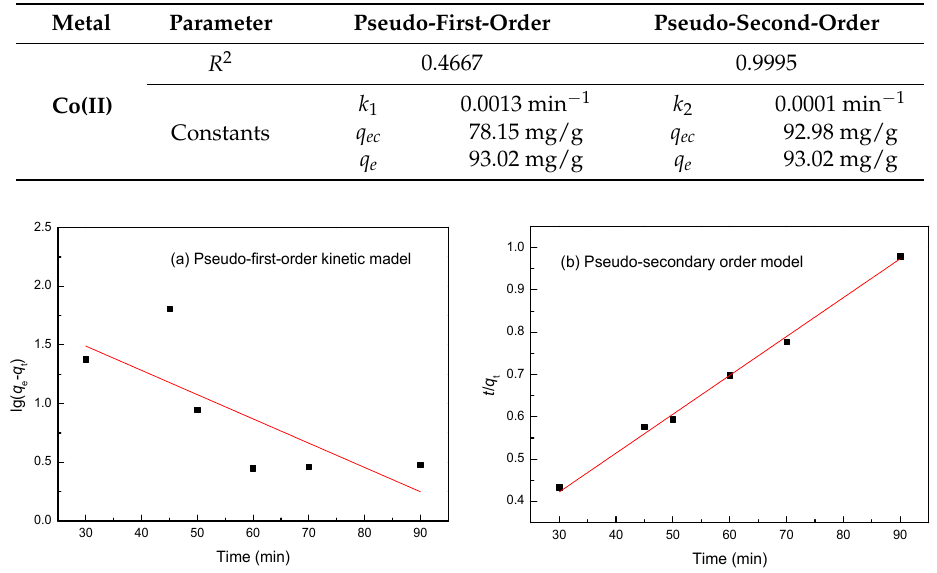
Figure 10. ( a ) Pseudo ‐ first ‐ order; and ( b ) pseudo ‐ secondary ‐ order adsorption kinetic equation fitting curves of the experimental data at a temperature of 75 °C, an initial Co(II) concentration of 0.0040 mol/L, and a pH of 5.6.